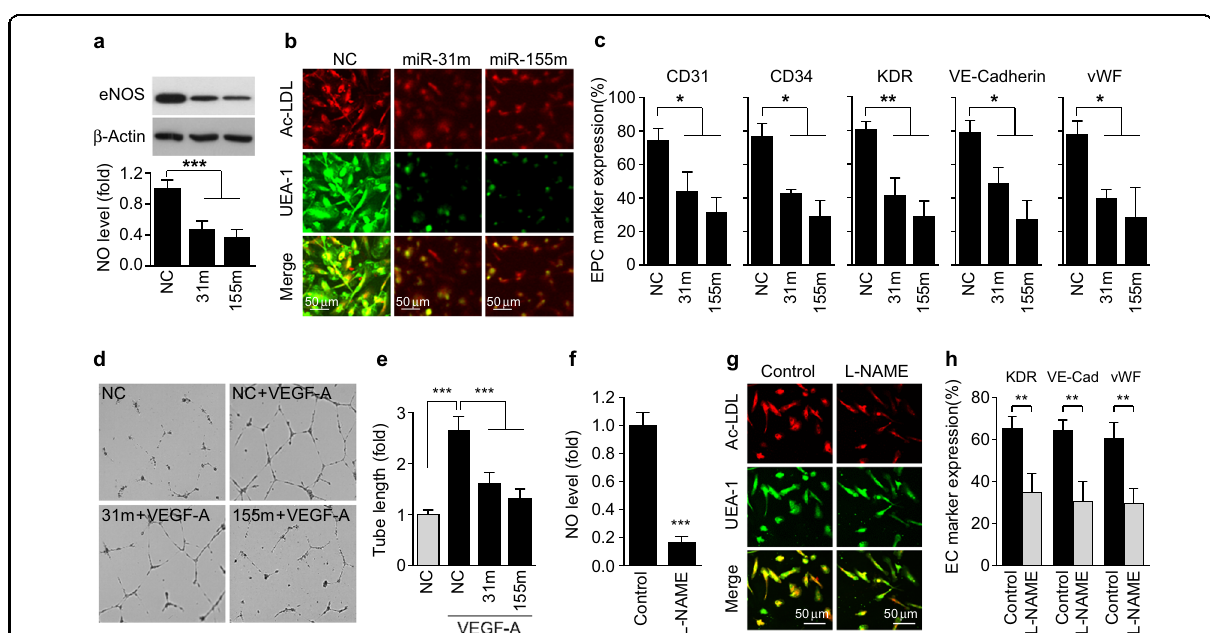
Fig. 7 miR-31/155 mimics and an eNOS inhibitor impair EPC differentiation. a – e CBMNCs were transfected with negative control (NC), miR-31 mimic (miR-31m or 31 m), or miR-155 mimic (miR-155m or 155 m) and differentiated into EPCs in fresh media. a The levels of eNOS protein and NO production were determined by western blotting and confocal microscopy ( n = 4). b Representative images of EPCs characterized by double- positive staining with Dil-ac-LDL and FITC-UEA-1. c The expression levels of EPC markers were analyzed by fl ow cytometry ( n = 3). d , e The angiogenic potential of EPCs was determined by a tube formation assay ( n = 4). f – h Adherent CBMNCs were cultured with or without L-NAME (1 mM) for 4 days. f Intracellular NO production was determined by confocal microscopy ( n = 4). g EPC differentiation was con fi rmed by staining with Dil-ac-LDL and FITC-UEA-1. h The expression levels of EPC markers were analyzed by fl ow cytometry ( n = 3). * P < 0.05, ** P < 0.01, and *** P <